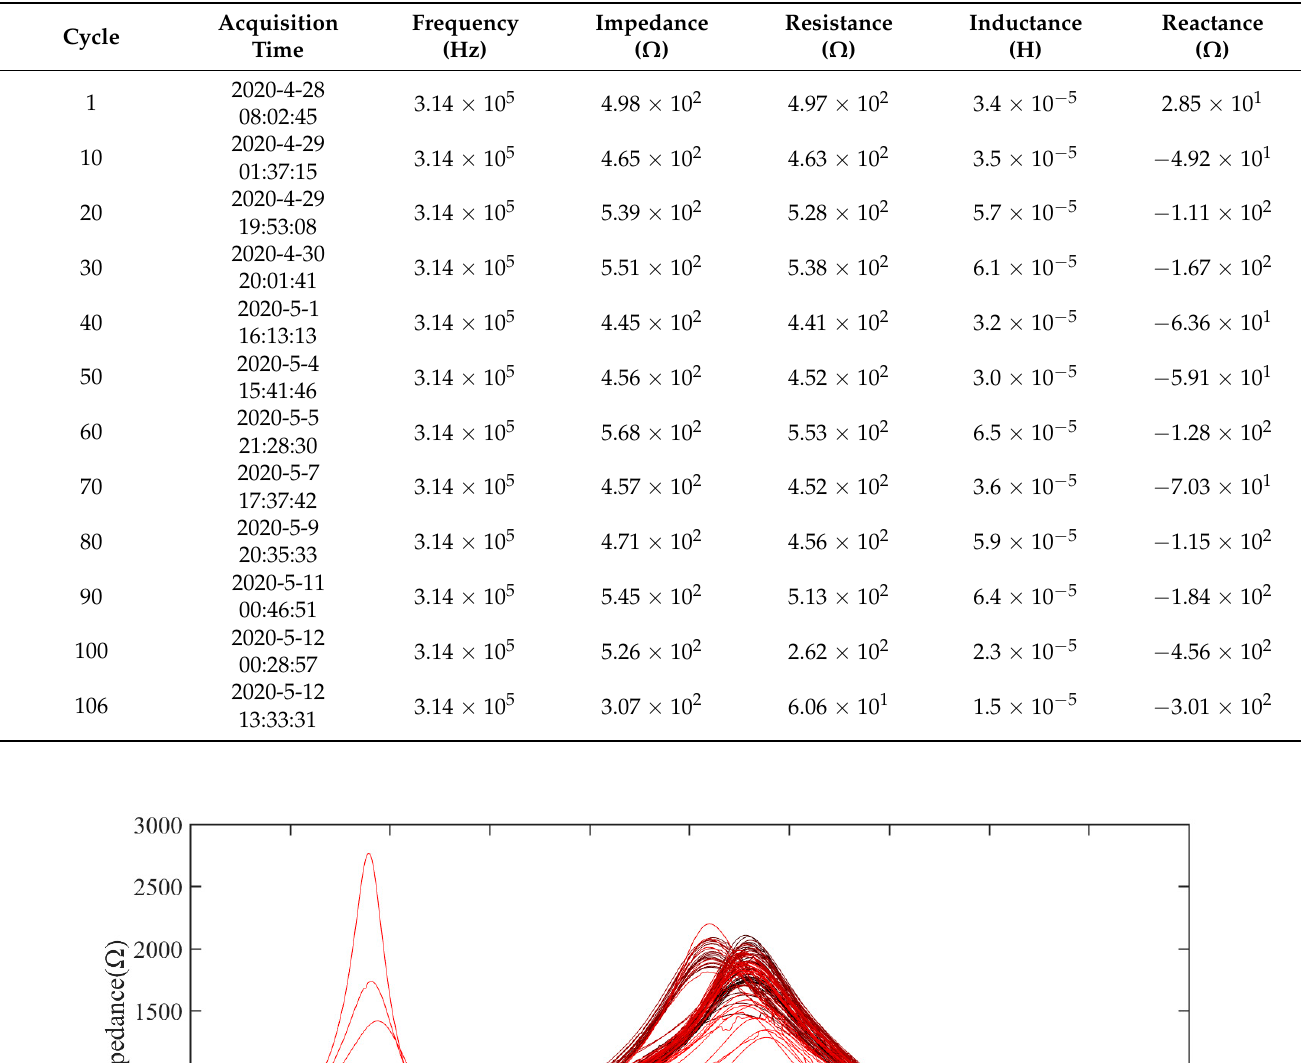
Table 2. Part of the data collected by LCR meter under the frequency of 314,050 Hz.